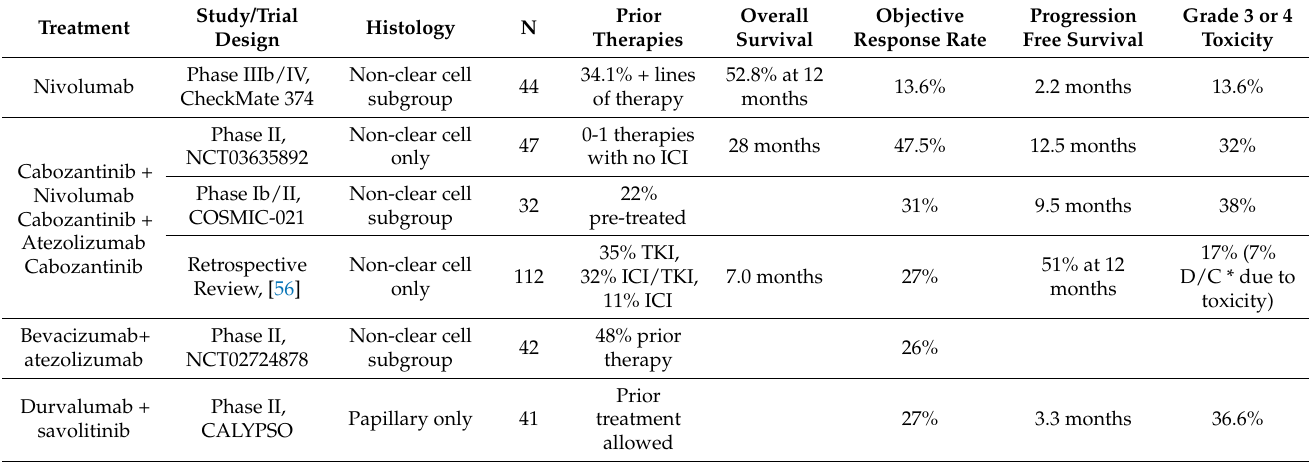
Table 4. Trials in refractory non-clear cell